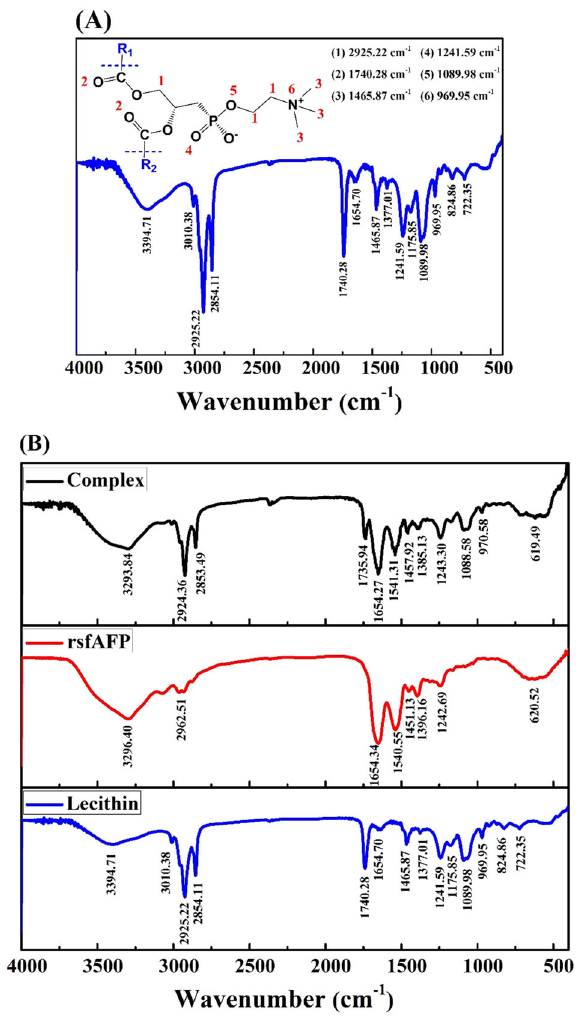
Fig. 6 Fourier transform infrared (FTIR) spectroscopic analysis. A Characteristic FTIR spectra of egg yolk lecithin head; B FTIR spectra of egg yolk lecithin, rsfAFP, and their